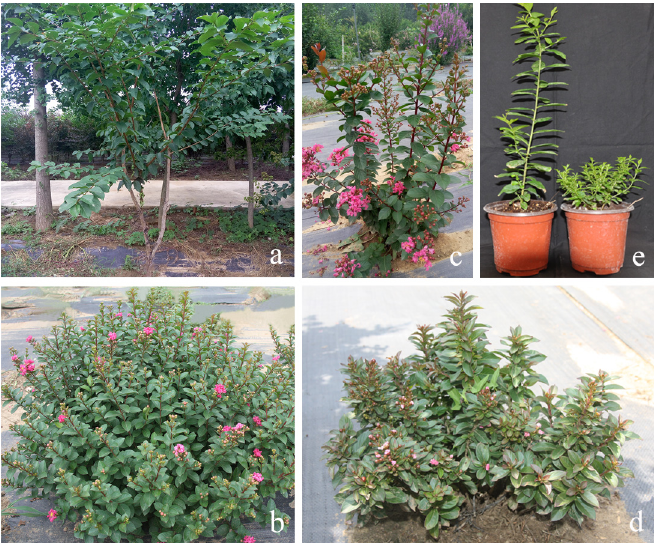
Fig 1. Plant materials used in this study. (a) Female parent, (b) male parent, (c) non-dwarf phenotype in the F 1 population, (d) dwarf phenotype in the F 1 population, and (e) two contrasting phenotypes in the BC 1 population.